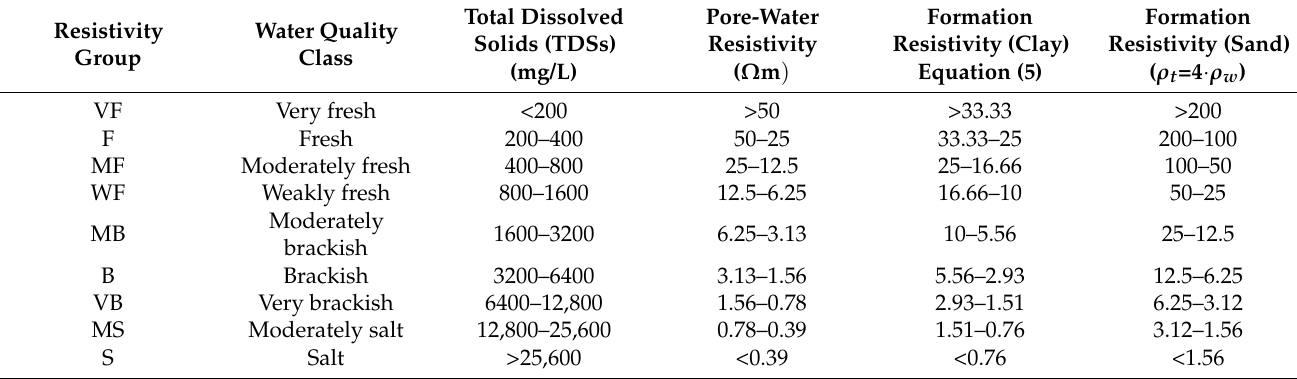
Table 1. Relation between groundwater resistivity and formation resistivity for the water-quality classes defined by De Moor and De Breuck